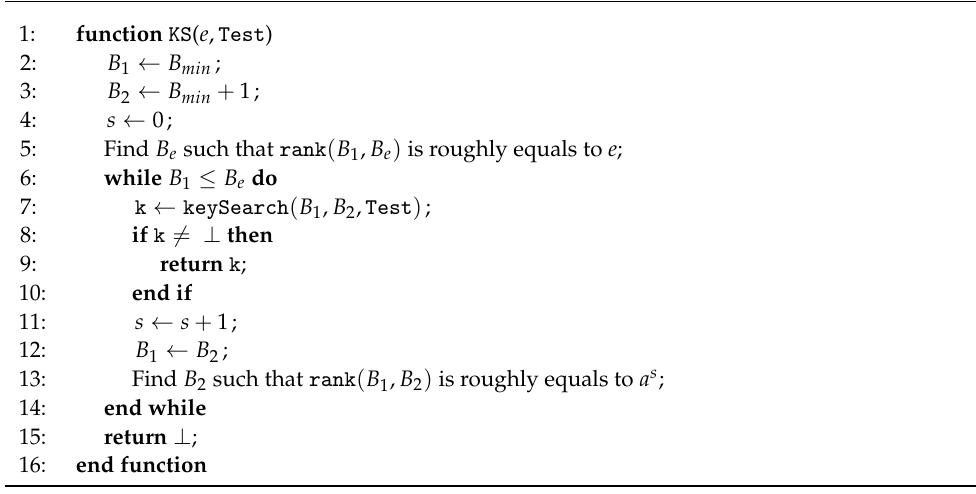
Algorithm 10 performs a non-optimal enumeration over an interval with roughly e full key candidates.